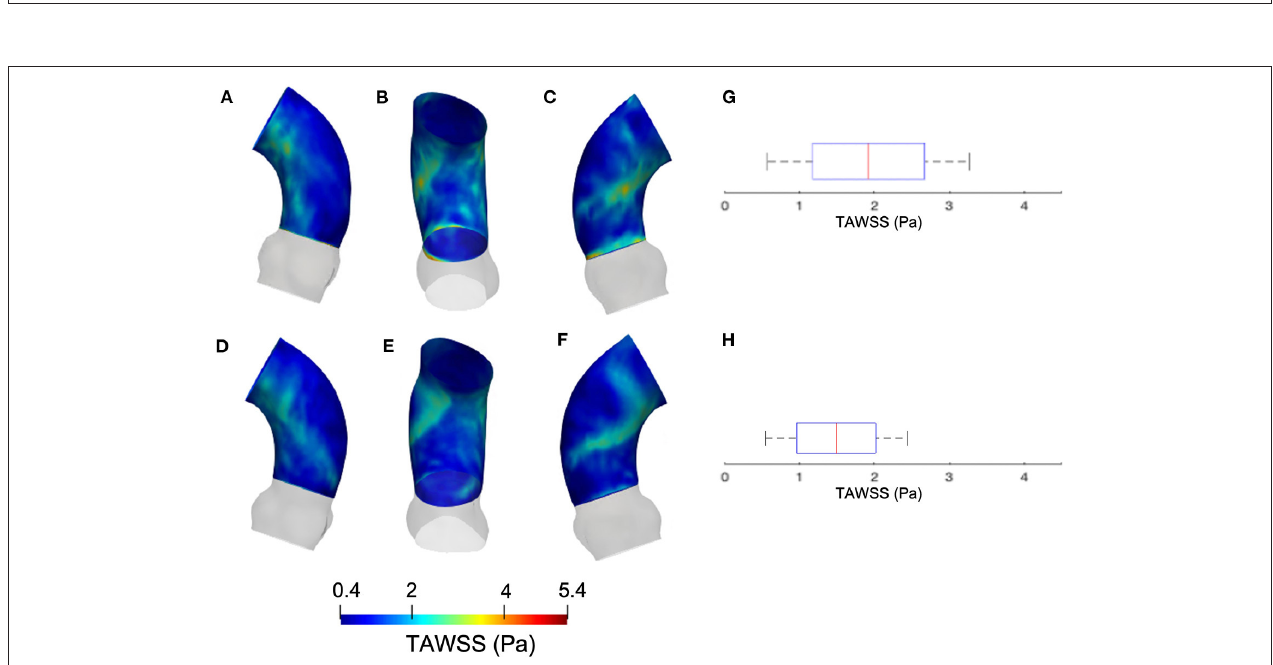
FIGURE 7 | Contour map of the WSS at p 0 [min: 0.4 Pa, avg: 4.9 Pa, max: 9.5 Pa] (A–C) and p 4 [min: 0.6 Pa, avg: 4.5 Pa, max: 8.6 Pa] (E–G) . Box plots of the WSS at both configurations (D,H) .